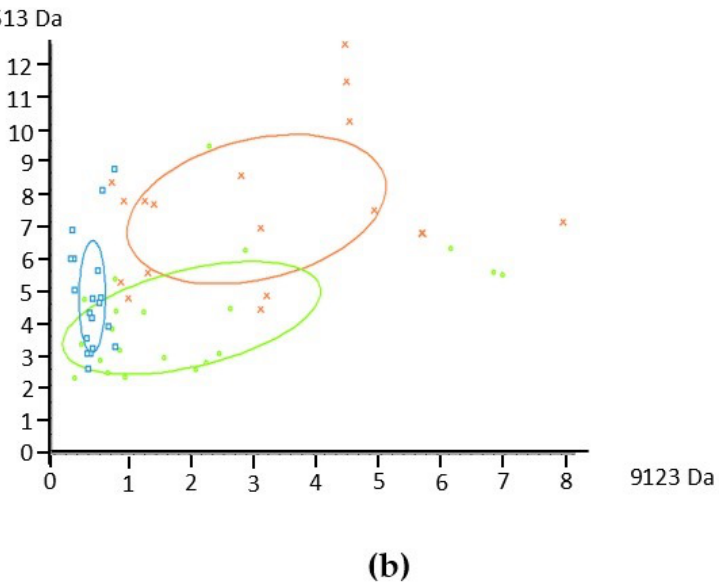
Figure 2. ( a ) Gel-like view and average spectrum. ( b ) 2D-plot protein spectra according to the intensities of m / z 3513 and m / z 9123 from colostrum (light red), transitional milk (light green) and mature milk (light blue) from OW/Ob mothers. Number of points = 54 (6 subjects, 3 milk types, 3